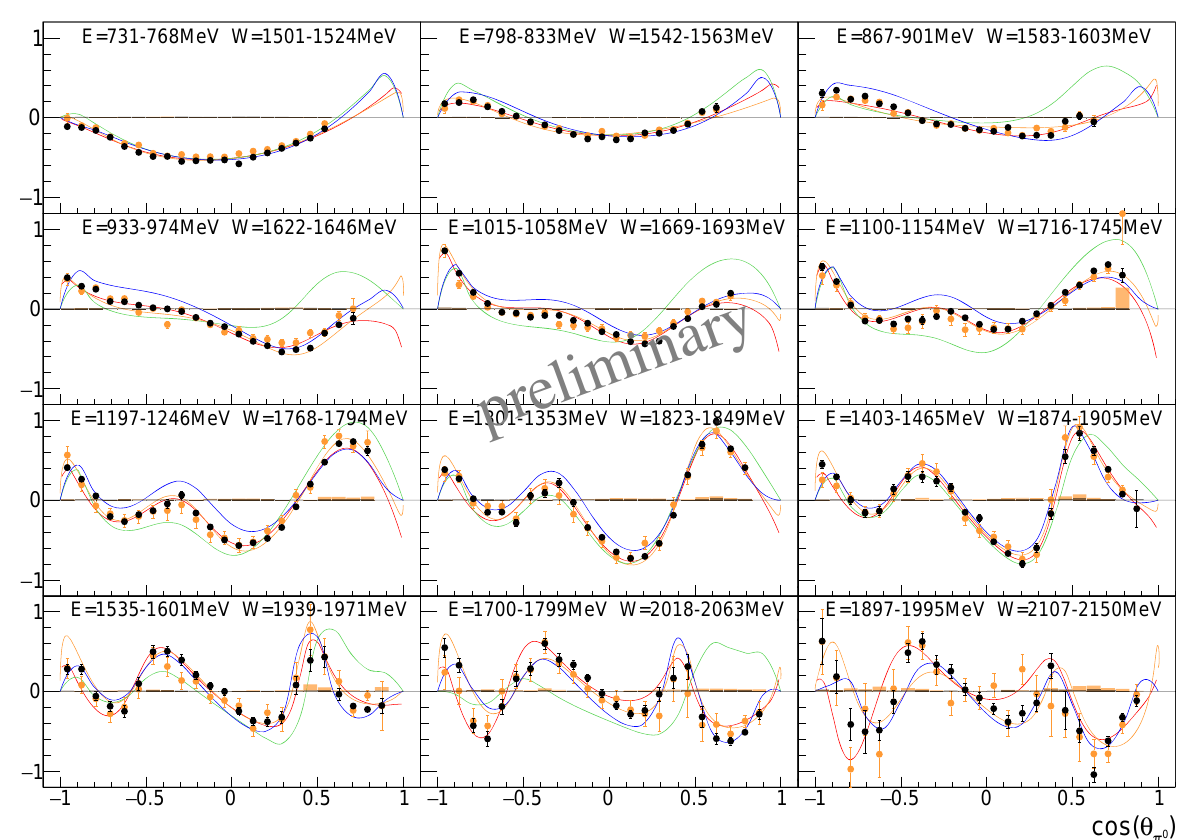
Figure 6. Preliminary results are shown for the polarization observable T , P for the p π 0 final state. This new data (black points), which was taken after the CB upgrade from December 2017 to October 2018, is compared to already published data of the CBELSA / TAPS collaboration [10, 11]. In addition, di ff erent PWA curves are plotted as well (JüBo-2017 (orange line) [16], BnGa-2014-02 (red line) [15, 41], SAID-CM12 (blue line) [17] and MAID-2007 (green line)